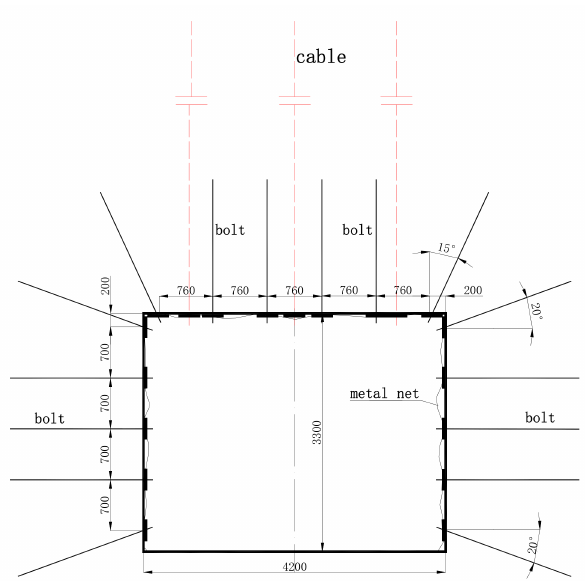
Figure 2. Layout diagram of the 1301 haulage roadway support parameters (units: